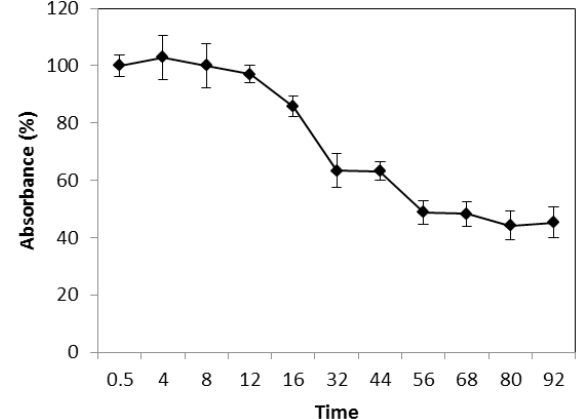
Figure 6. Inhibitory effect of 40 µg mL -1 LcPR4a on A. lentis growth. Significant reduction in fungal biomass was ob - served at 32 hours post treatment (hpt) ( P 0.009). Each time point indicates relative fungal biomass in the presence of 40 µg mL -1 LcPR4a, expressed as percentage absorbance of the control cultures. Bars indicate standard errors